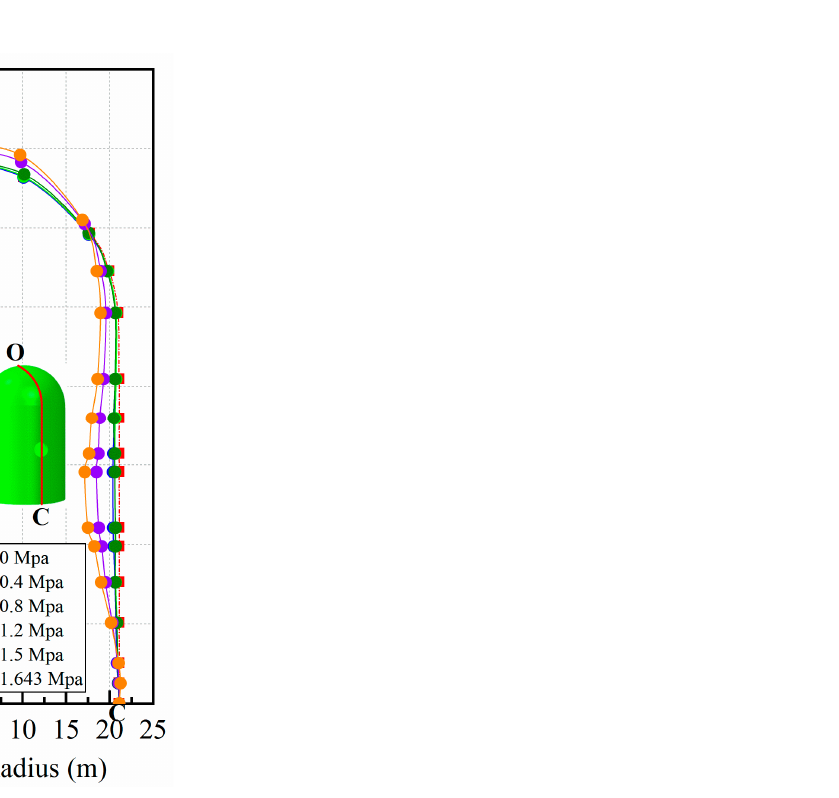
Figure 8. Displacement contour of the conventional containment on a large scale of 1:25 (Note: point O is at the top of the dome and point C is at the bottom of the containment) .